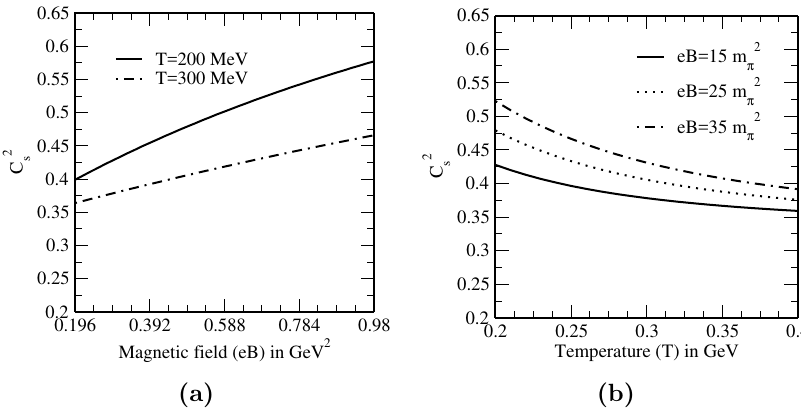
Figure 7 . The variation of square of the speed of sound with strong magnetic (cid:12)eld at various temperatures (a) and the variation with temperature in the presence of di(cid:11)erent strong magnetic (cid:12)elds